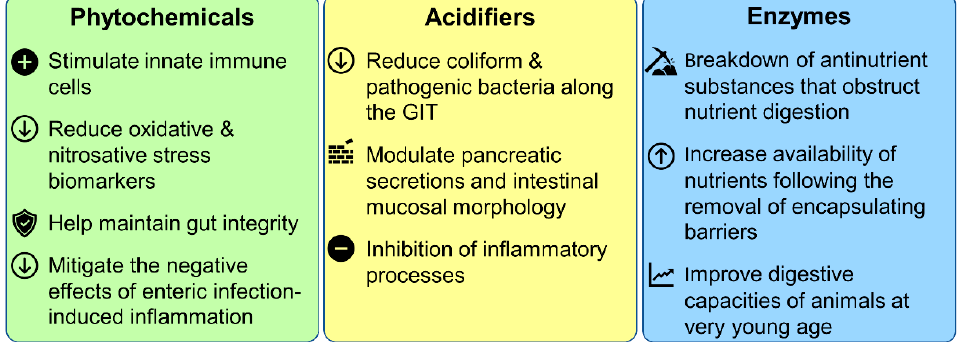
Figure 3. Modes of action of phytochemicals, acidifiers, and enzymes as growth